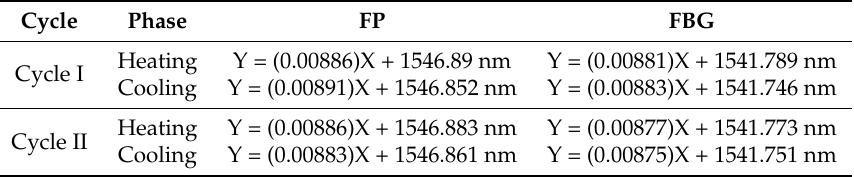
Figure 15. Thermal Cycle II: ( a ) heating; and ( b ) cooling. Table 4. Linear Regression of Sensor Response to Temperature in Figures 14 and